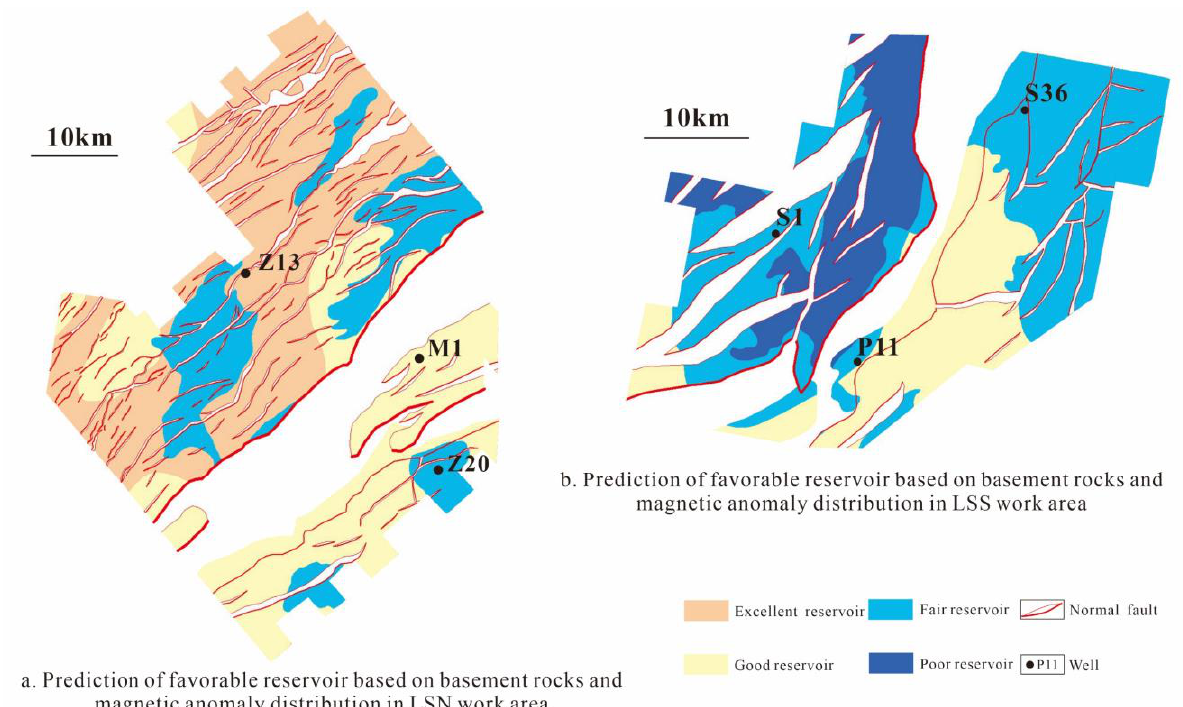
Figure 13. Prediction of favorable reservoir areas based on the basement rocks and magnetic anomaly distribution. Note: Figure 11a,b show the prediction of favorable reservoirs in the LSN and the LSS work areas respectively based on the distribution of magnetic anomalies and basement lithology.